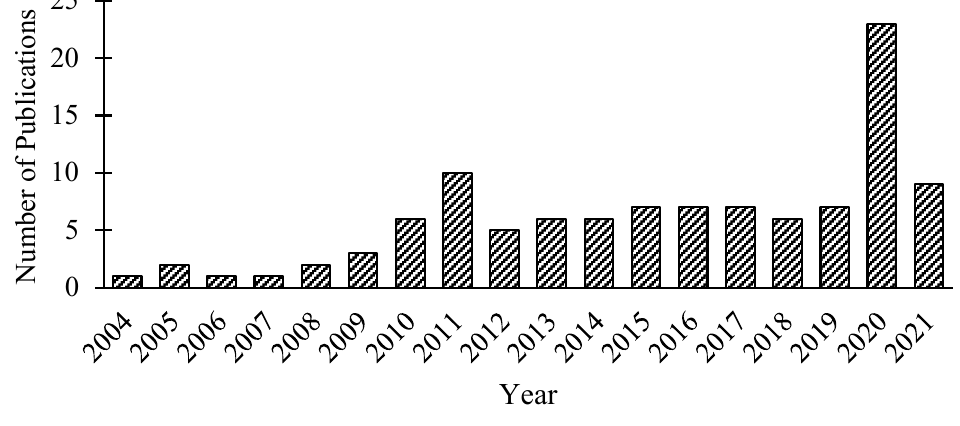
Figure 4. Publication trend for machine learning applications in blast-induced impact predictions.